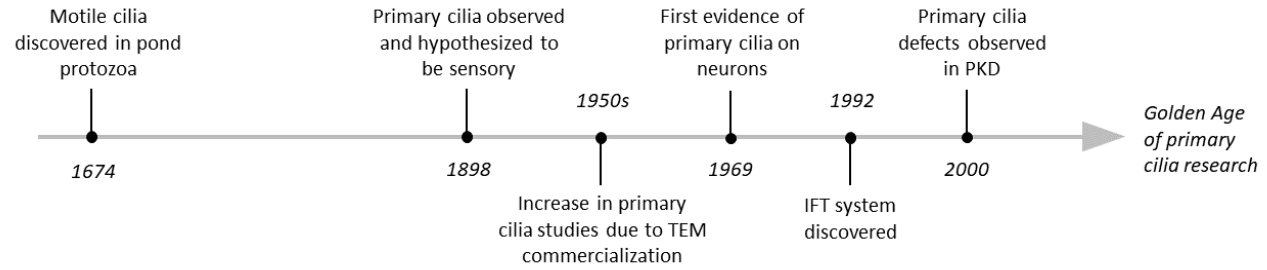
Figure 1. Key events in primary cilia research history. Schematic illustration of the timeline of the major discoveries in the field of primary cilia. (TEM) Transmission electron microscopy, (IFT) Intraflagellar transport, (PKD) Polycystic kidney disease.